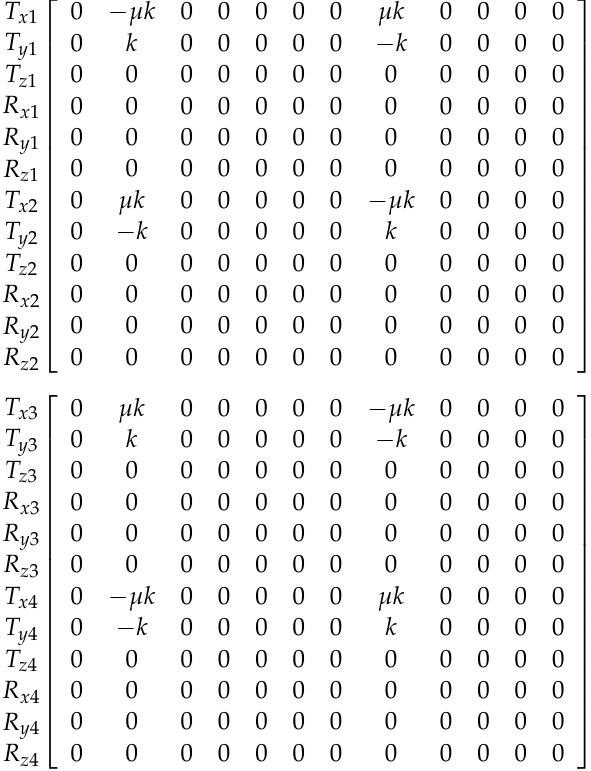
Figure 2. Contact condition between brake pad and disk.